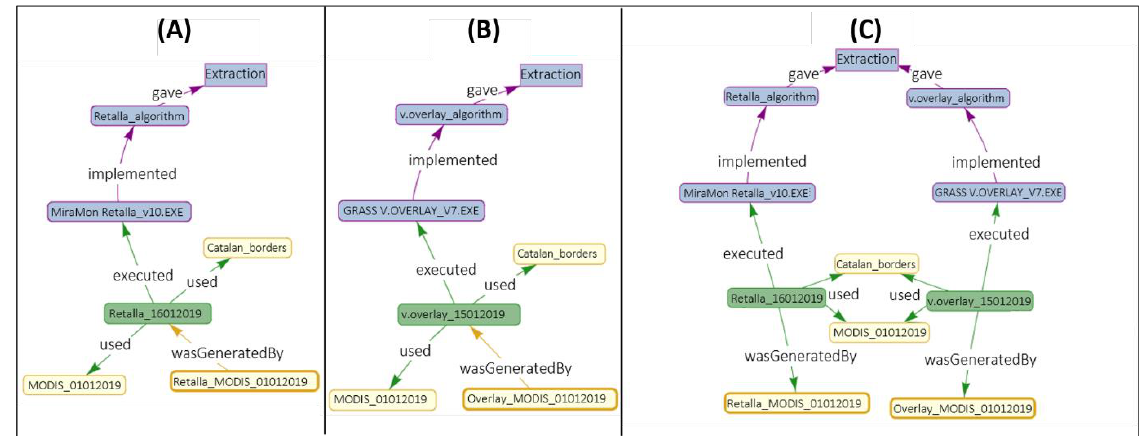
Figure 4. Graph ( A , B ) represent individual executions with the same functionality carried out with MiraMon and GRASS, respectively. ( C ) represents provenance of the two executions merged into one.